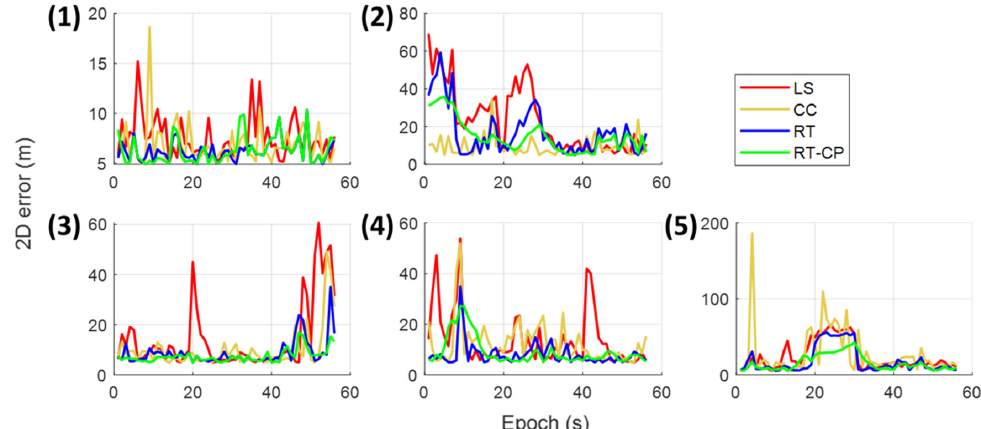
Figure 24. The solutions of different positioning algorithms applied on the GNSS measurements from the proposed simulator on different scenarios, including the least squares positioning method (LS), the least squares method with consistency check (CC), the 3DMA GNSS ray-tracing positioning method (RT), and the 3DMA GNSS ray-tracing based collaborative positioning with factor graph optimization (RT-CP). The sub-figures ( 1 )–( 5 ) are corresponding to the positioning solutions for Agent 1–5 in Figure 23.